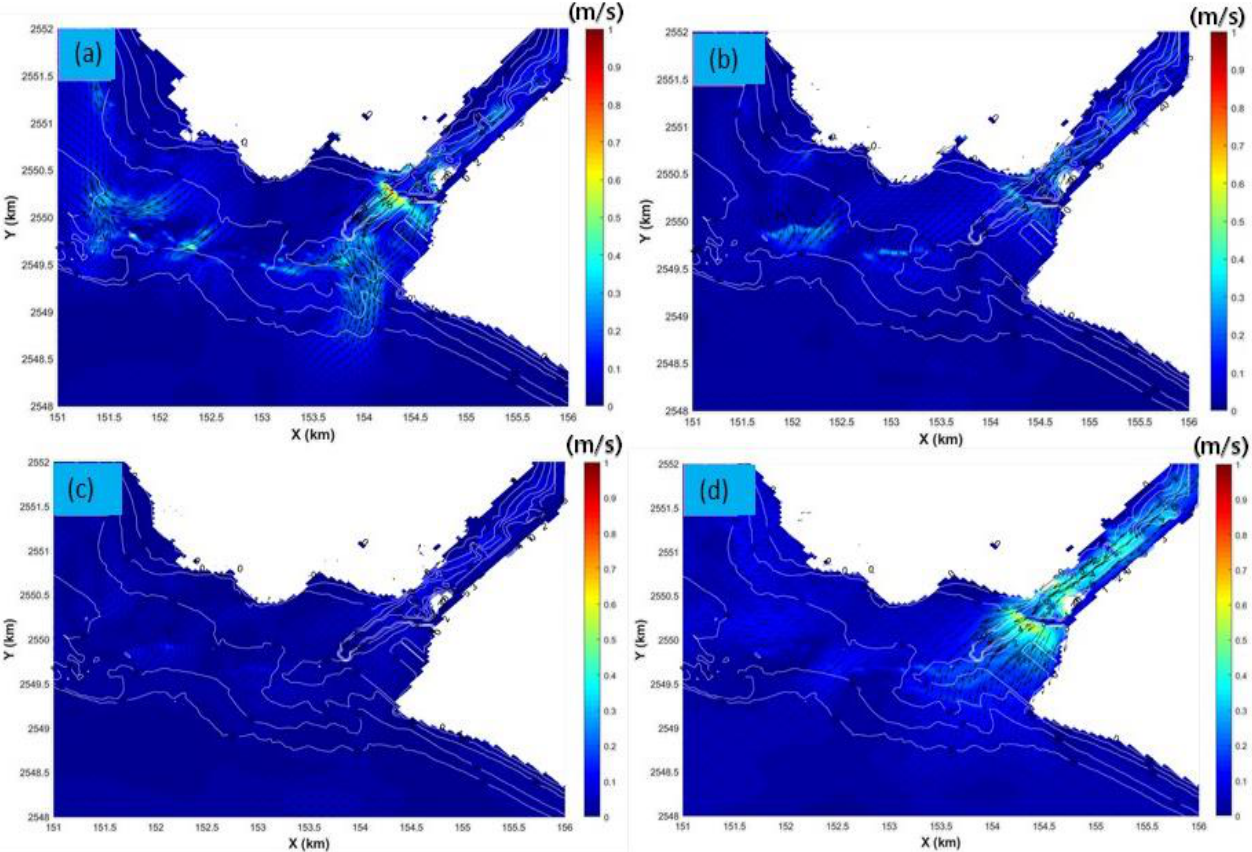
Figure 9. The simulated flow field during different tidal hours under the condition of ( a ) the maximum ebb with energetic waves, ( b ) flood tides with moderate waves, ( c ) the maximum flood tide with mild waves, and ( d ) ebb tide with mild waves (color: flow speed, scale on the right, contour: depth).